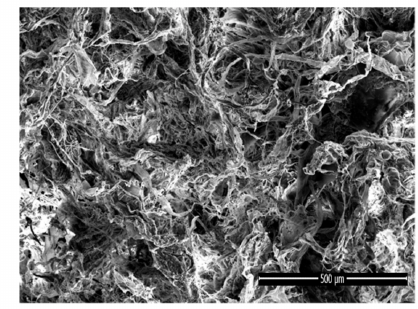
Figure 5. SEM image of PLA-PVA porous bioscaffold.